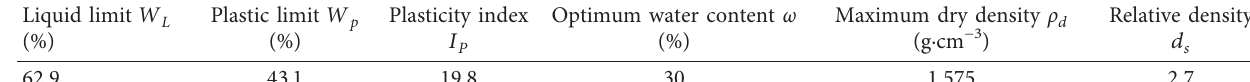
Figure 1: Schematic diagram of the soil extraction position. Table 1: Basic physical properties of red clay.